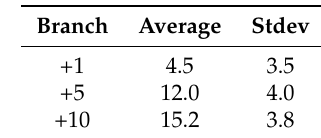
Table 2. Predicted number of remaining bugs.